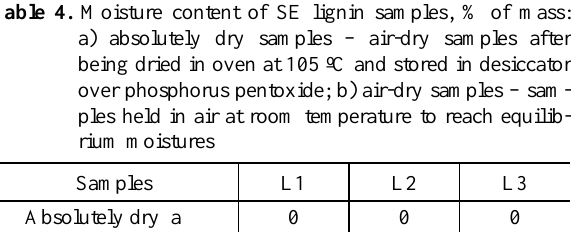
Table 4. Moisture content of SE lignin samples, % of